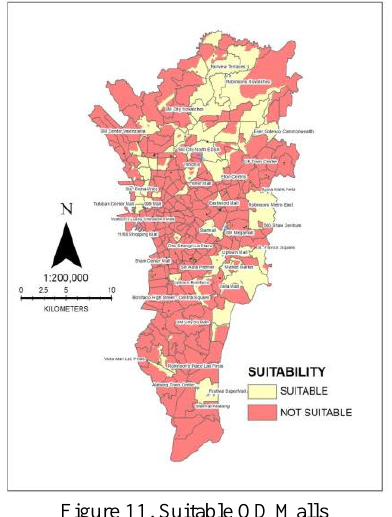
Figure 9. Total Number of Trips